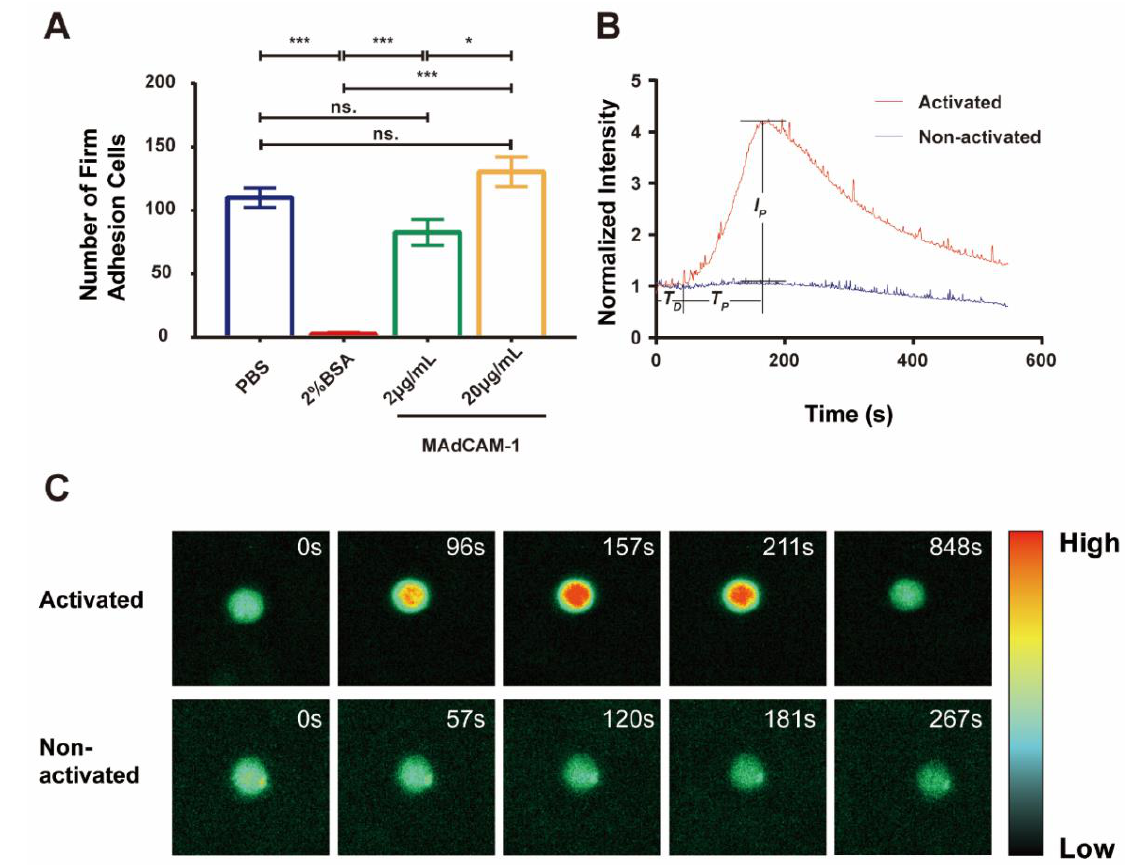
Figure 2. Calcium bursting of firmly adhered RPMI 8226 cells on MAdCAM-1 substrate under flow. ( A ) Number of firmly adhered RPMI 8226 cells on substrates coated with PBS, 2% BSA only, or plus MAdCAM-1 (2 and 20 µ g/mL) under shear stress of 0.3 dyn/cm 2 . The data represent the mean ± standard error of the mean (SEM) from three independent experiments. The significance of the difference is shown by p -value, with ns. for p > 0.05, * for p < 0.05, and *** for p < 0.001. ( B ) The time course of the normalized fluorescence intensity of activated (red) or non-activated (blue) calcium signaling cells on the 20 µ g/mL MAdCAM-1 substrate over the observation time. T D , delay time; T P , peak time; I P , normalized peak intensity. ( C ) Two series of fluorescence pseudo-color images are shown to illustrate the activated calcium signaling of firmly adhered RPMI 8226 cells and the non-activated one on 20 µ g/mL MAdCAM-1 at different time points.